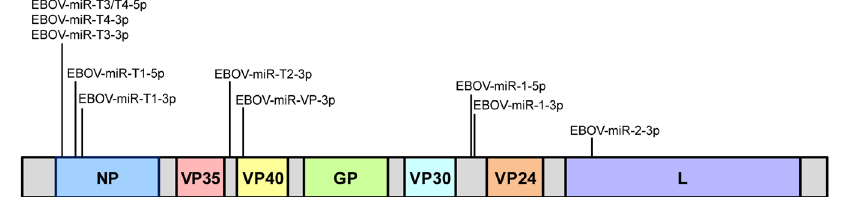
Figure 1. Ten of twelve candidate EBOV miRNAs align to viral genome. Putative miRNA sequences were aligned to the UCSC Ebola Genome Browser using a BLAT search of the Zaire ebolavirus isolate Ebola virus/H. sapiens-wt/SLE/2014/Makona-G3686.1 reference sequence, with relative positions denoted. Genome segments are not drawn to